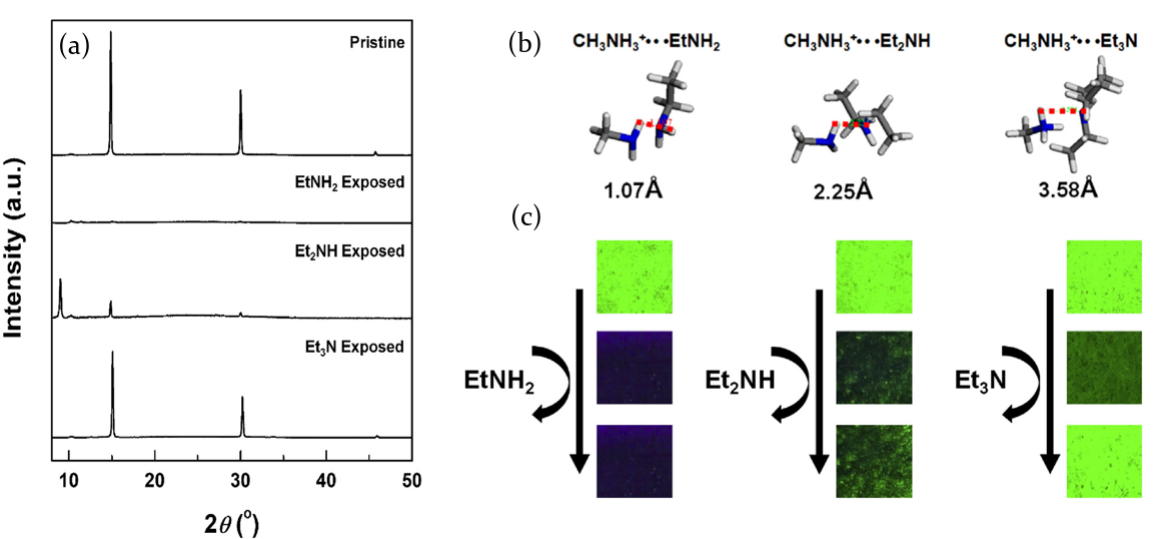
Figure 13. ( a ) X-ray diffraction (XRD) patterns of CH 3 NH 3 PbBr 3 films before amine exposure (pristine), after exposure to EtNH 2 , Et 2 NH and Et 3 N. ( b ) Interaction distances between MA + of perovskite and aliphatic amines obtained through DFT calculation. ( c ) Photographs of MAPbBr 3 perovskite films recorded under 365 nm UV light after exposure to EtNH 2 , Et 2 NH and Et 3 N. Reprinted from [96]. Copyright © 2017, with permission from